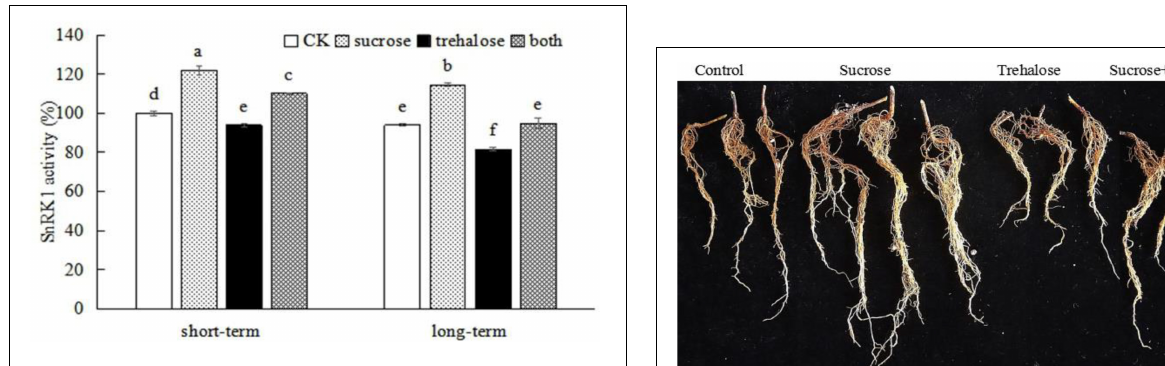
FIGURE 4 | Exogenous sucrose affects SnRK1 enzyme activity in peach roots. Error bars represent the averages of three biological replicates ± SD. Different letters represent differences between different processes. Significance was defined at P < 0.05.